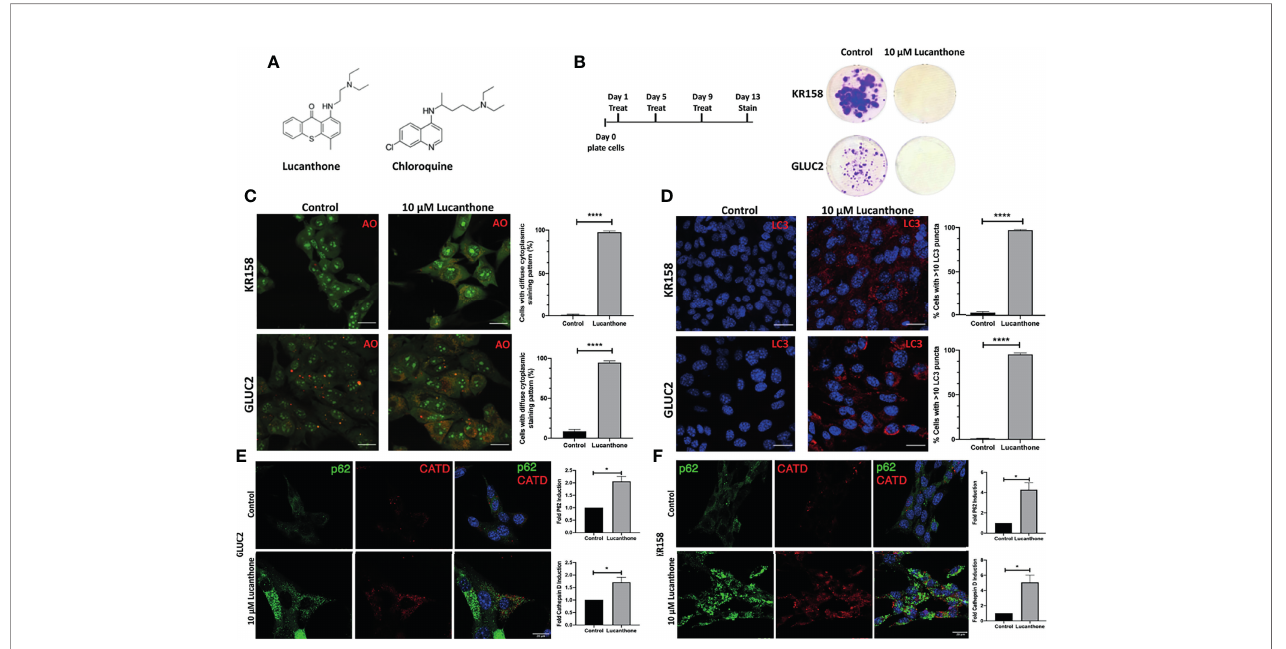
FIGURE 1 | Lucanthone compromises glioma cell growth. (A) Chemical structures of lucanthone and chloroquine. (B) Effects of long-term treatment of KR158 and GLUC2 cultures with 10 m M lucanthone on glioma cell proliferation. (C) Acridine orange (AO) marks lysosomes as punctae staining after 48 hour of lucanthone treatment. (D) LC3 marks autophagosome punctae levels after 48 hour treatment with lucanthone. (E, F) Effect of lucanthone on P62 and Cathepsin D levels in GLUC2 and KR158 cells, respectively. Scale bar = 30 m m. Bars are mean +/- SEM. N= 3-4 independent experiments. *p < 0.05, ****p < 0.0001, student ’ s